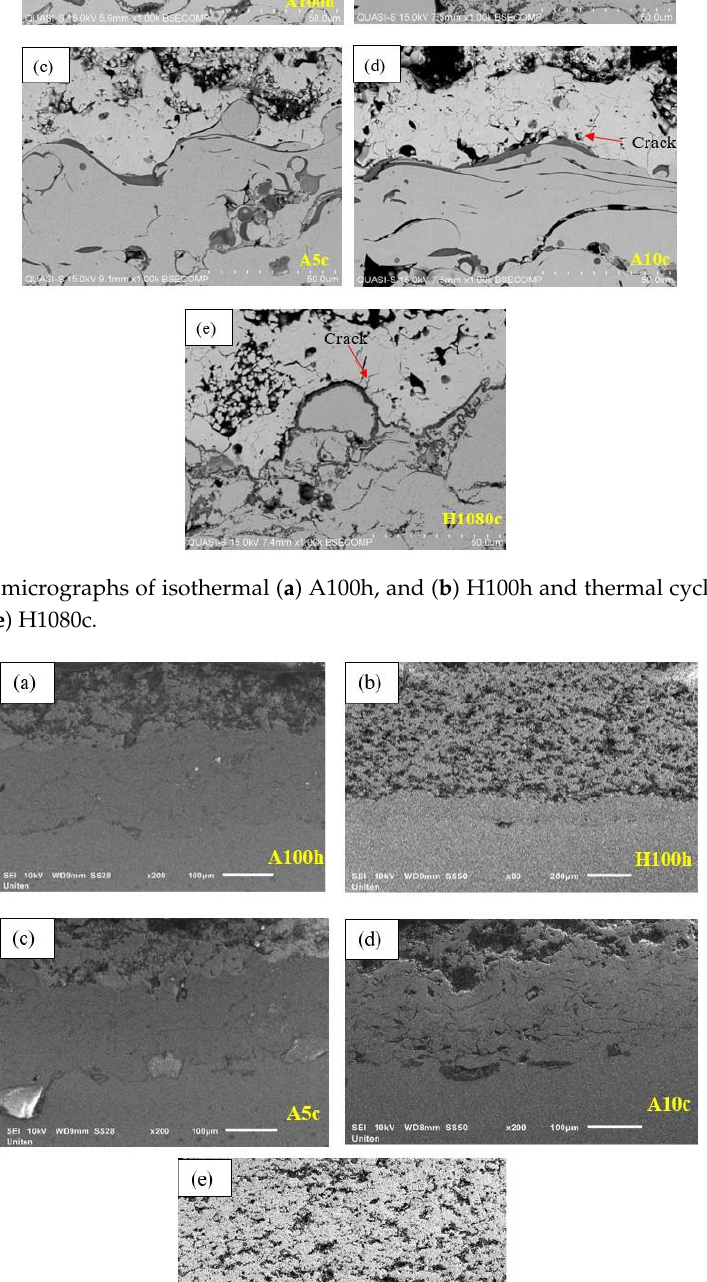
Figure 4. Mixed oxide ratio of APS-bondcoat and HVOF-bondcoat.